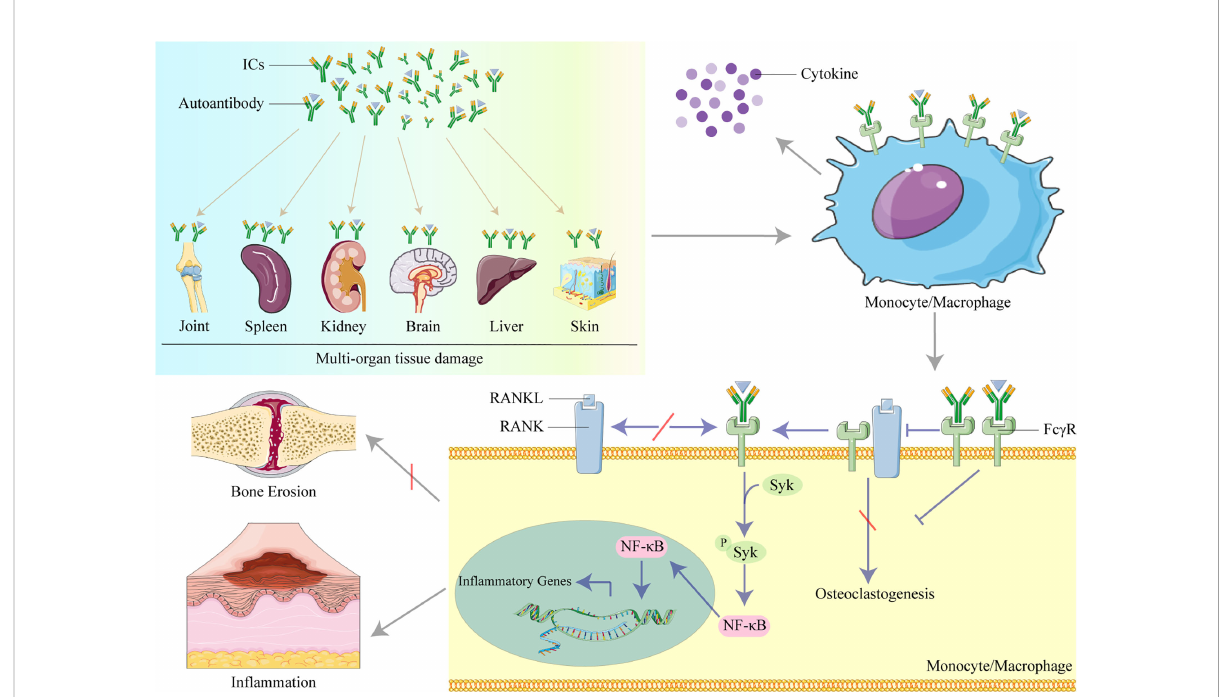
FIGURE 1 The role of IgG in organ and tissue damage in systemic lupus erythematosus (SLE). Lupus IgG and immune complexes (ICs) deposited in several organs and tissues cause multi-organ and tissue damage. IgG and ICs binding to Fc gamma receptors (Fc g Rs) activate monocytes/macrophages to secret cytokines. IgG inhibits osteoclastogenesis induced by the receptor activator of nuclear factor kappa B ligand (RANKL) to protect against bone erosion by binding to Fc g RI and induces in fl ammation by activating the spleen tyrosine kinase (Syk)/nuclear factor kappa B (NF- k B) signal pathway to upregulate the transcription of in fl ammatory genes in